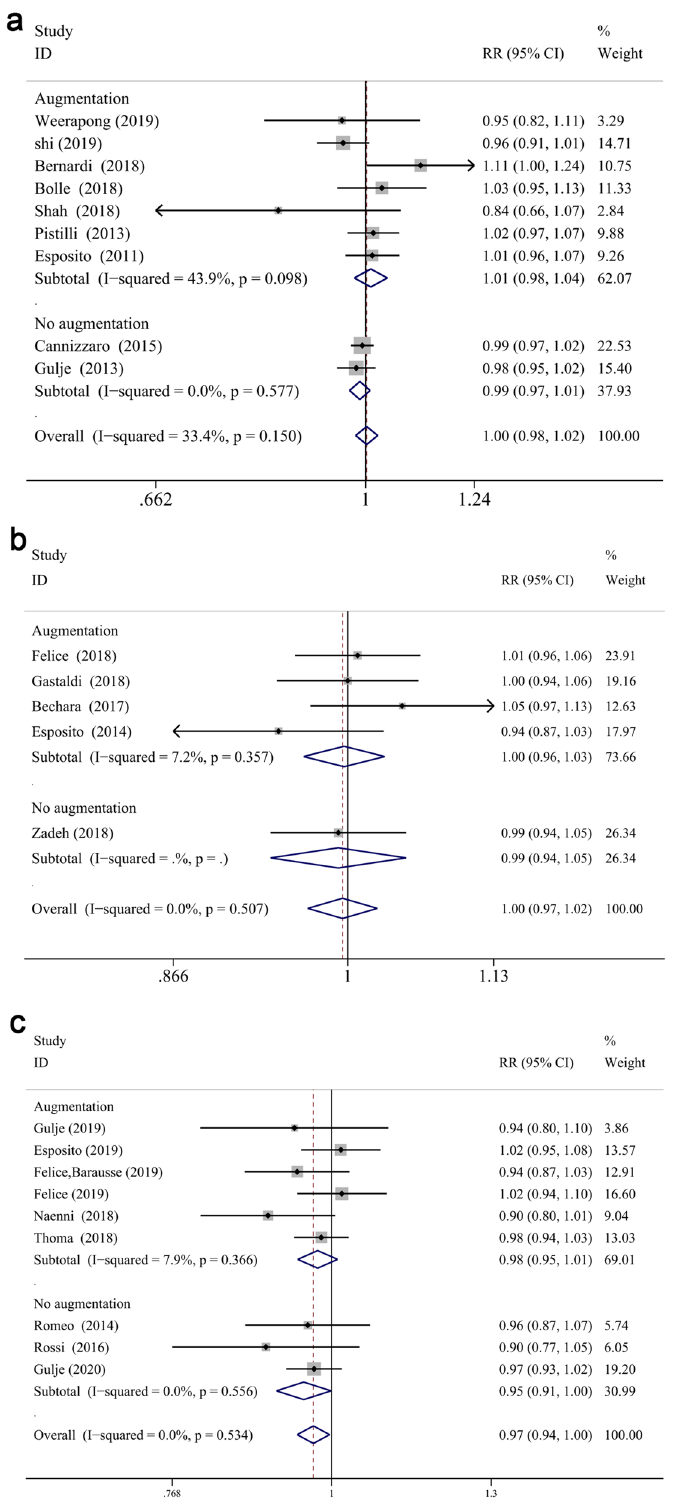
Figure 4. Subgroup analyses for the effects of bone augmentation on survival rate at 1-year ( a ), 3-years ( b ), 5-years ( c ) follow-up. Mantel–Haenszel (MH)-weighted RR < 1 indicated a lower survival rate of extra-short implants than the longer